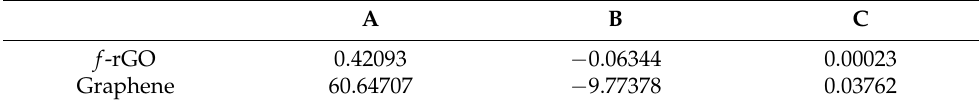
Table 1. Fitting parameters for both temperature sensors.